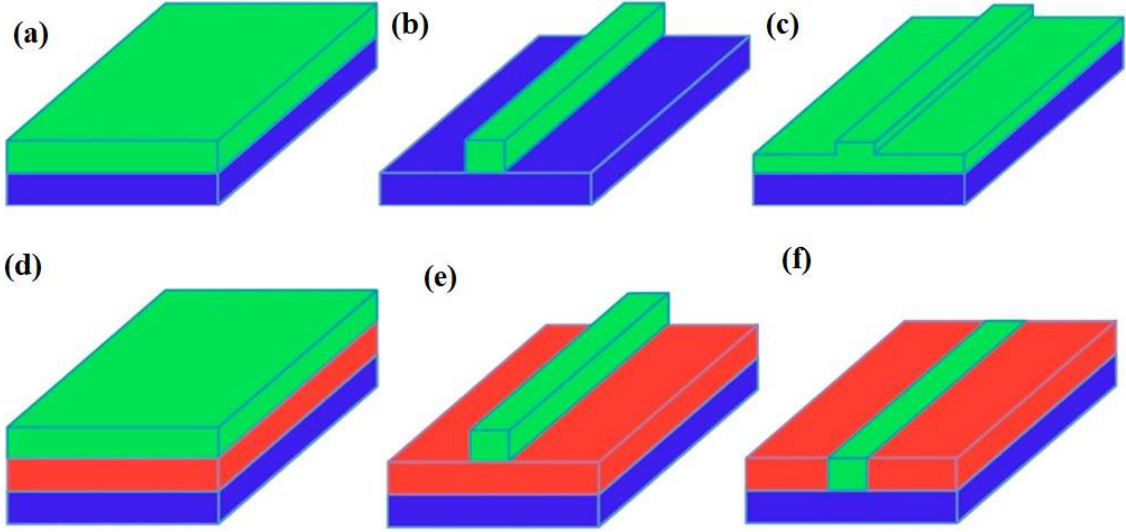
Figure 4. Illustration of common thin-film waveguide geometries: ( a ) slab waveguide, ( b ) strip waveguide, ( c ) rib waveguide, ( d ) slab waveguide, ( e ) ridge waveguide, and ( f ) embedded/buried waveguide. The same functional layers are marked with the same colors: green = waveguide layer (nc), red = optical buffer layer (nb), blue = substrate (ns). Reproduction requires permission from ref. [90]. Copyright 2006 the American Chemical Society.